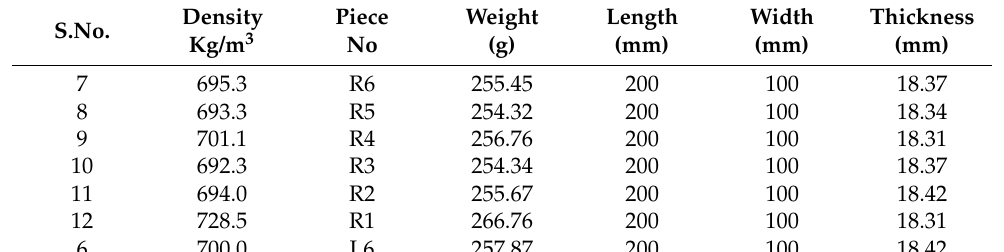
Table 18. Internal bonding test results.